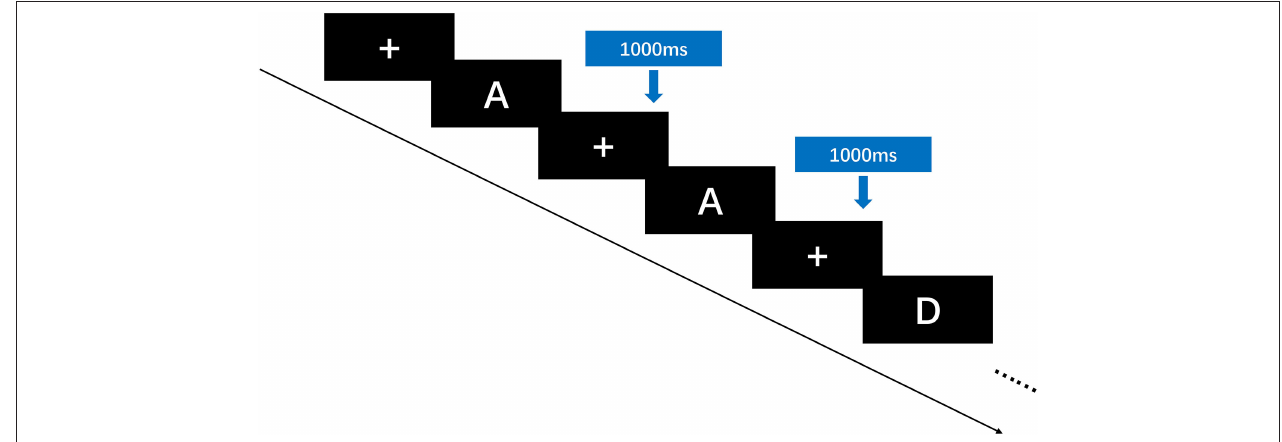
FIGURE 3 | In the 1-back task, participants need to determine whether a letter appears the same as the one before it. In the 2-back task, participants need to determine whether a letter appears the same as the two before it. If the same, press “F”; if different, press “J”. The maximum reaction time is 1000ms.